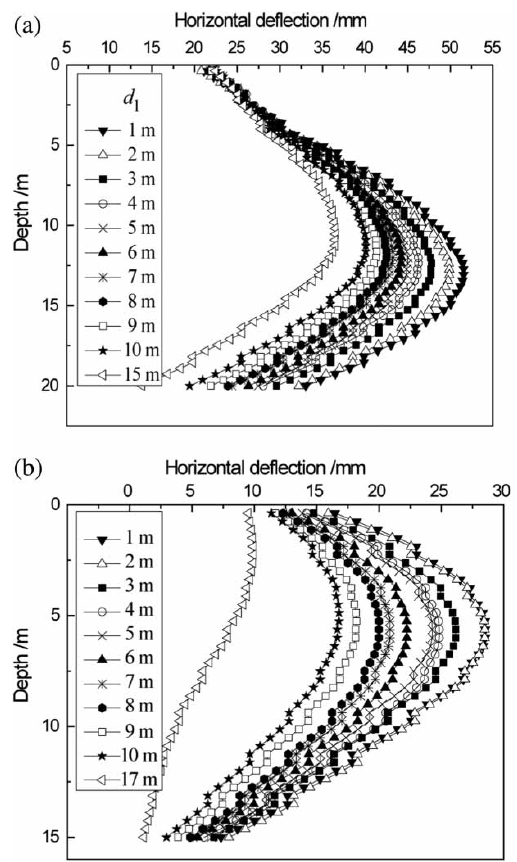
Fig. 11. Wall horizontal deflection at final excavation level for different distances between the two walls: (a) outer wall and (b) inner wall